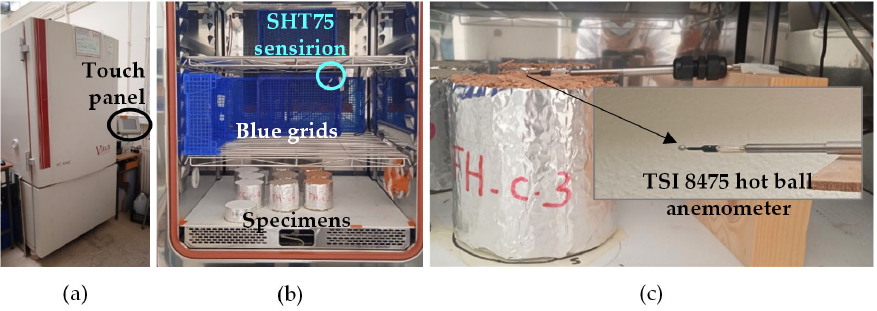
Figure 1. MBV experimental setup: ( a ) climatic chamber; ( b ) air velocity control ( c ) hot ball anemometer.